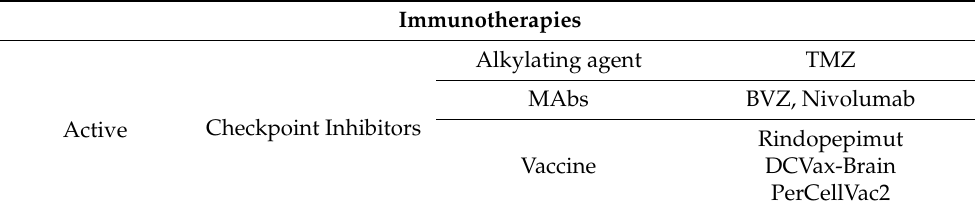
Table 3. Classification of immunotherapies for malignant brain tumors.